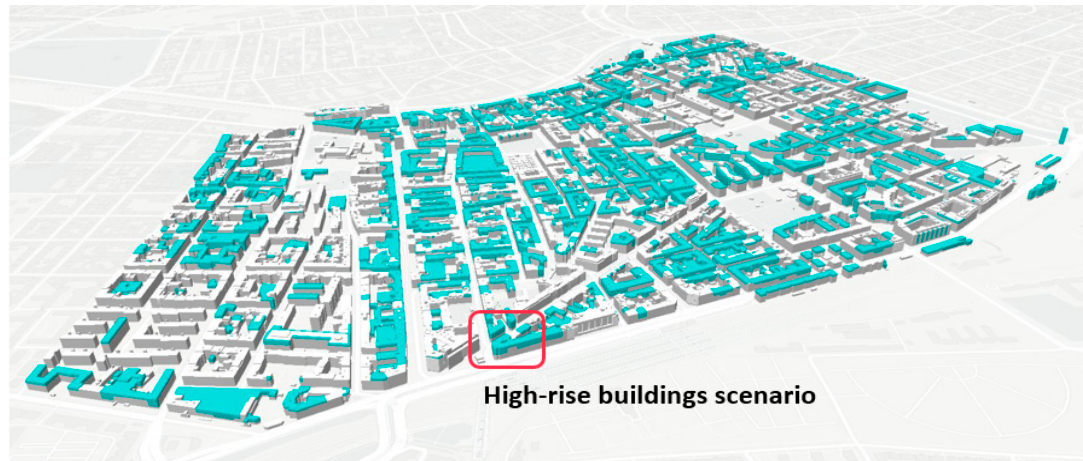
Figure 2. 3D model of the study area: Densification scenario including the volumes for maximum allowable building height (marked in blue) and the location of a hypothetical high-rise buildings cluster.